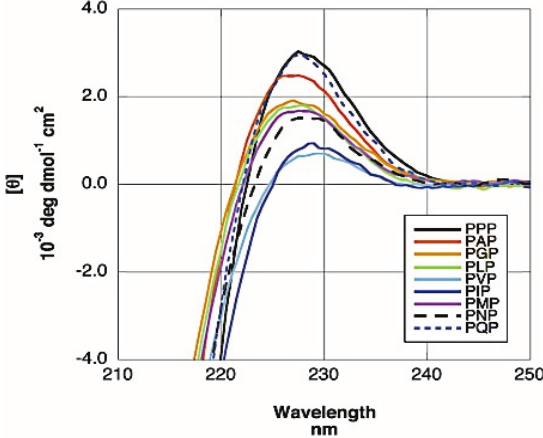
Figure 13. UV-CD spectra around the maximum dichroism value for PPP, PAP, PGP, PLP, PMP, PIP, PVP, PNP, PQP. (Taken from ref. [163] with